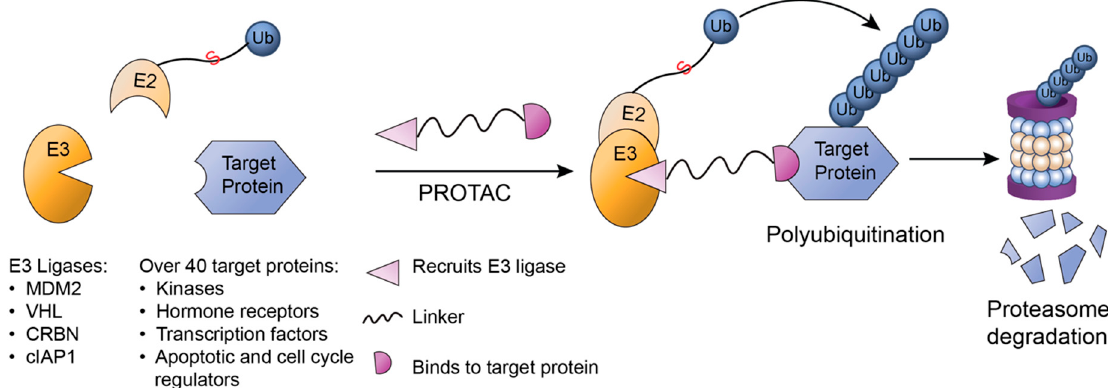
Figure 8. Proteolysis targeting chimeras (PROTACs). PROTAC links E3 ligases to target proteins, facilitating ubiquitination and eventual degradation. A PROTAC molecule has three subunits: one that binds to target protein, one that recruit a E3 ligase, and finally a linker connecting both parts. PROTAC induces the formation of a ternary complex, in which an E3 ligase bound to E2~Ub ubiquitinates the target protein and leads to subsequent proteasomal degradation.